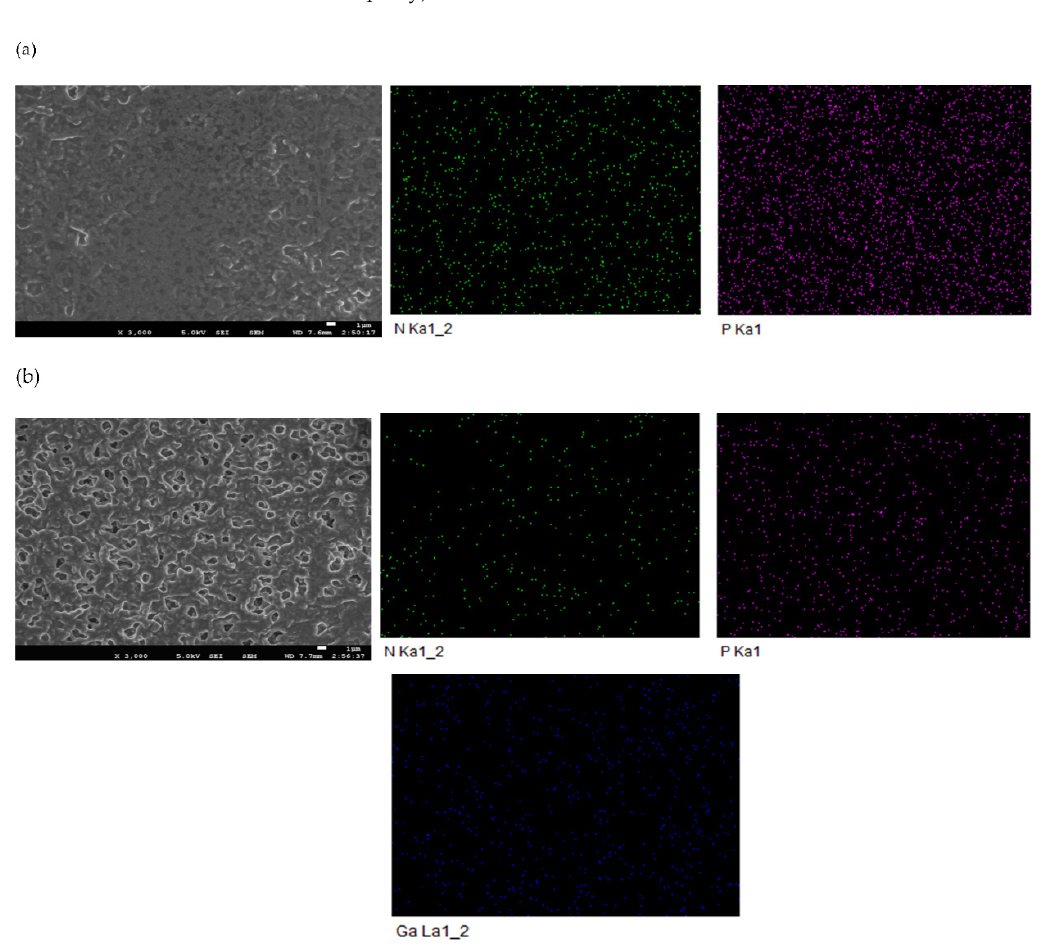
Figure 9. SEM images and EDS elemental mapping of SLM containing R 4 NCy before ( a ) and after ( b ) transport. ([Ga(III)]feed:400 mg/L, Acidity: 6 M HCl, Carrier: Bif-IL (R 4 NCy), Strip: pH = 1; Time: 8 h).